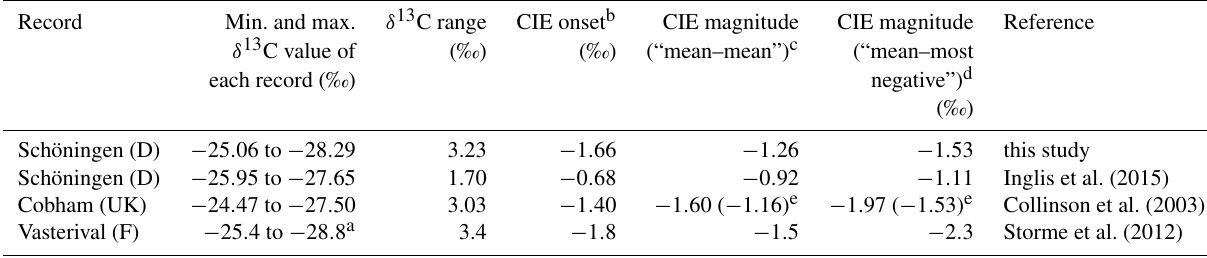
Table 1. Compilation of δ 13 C TOC datasets from European lignite deposits.